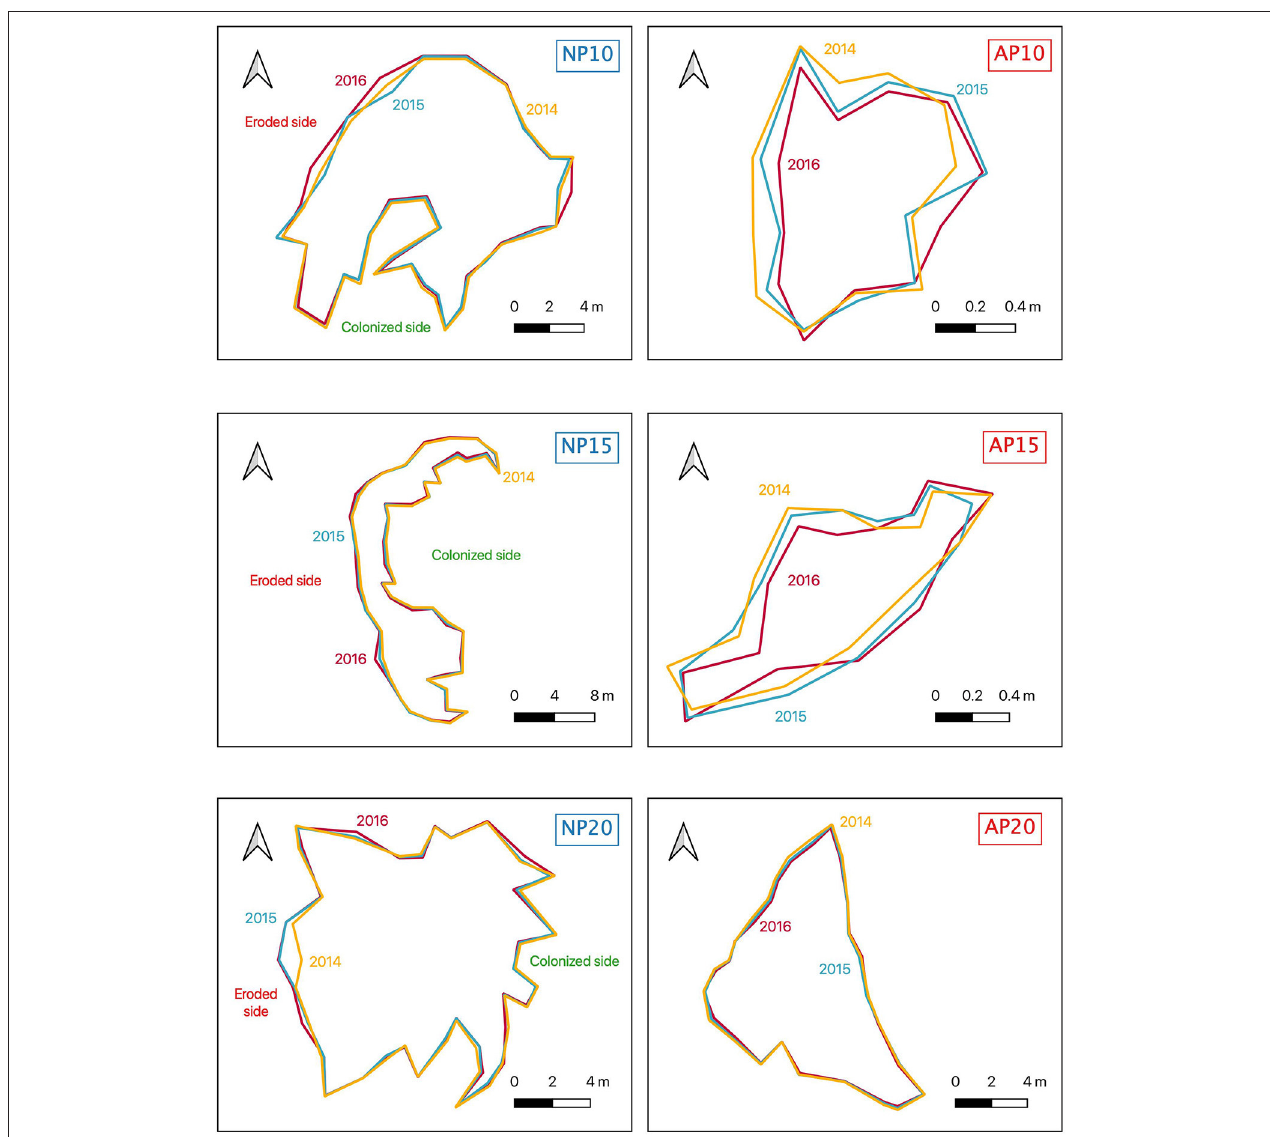
FIGURE 5 | Maps of the borders of natural (NP10, NP15, NP20) and anchoring patches (AP10, AP15, AP20) in 2014 (yellow), 2015 (blue), and 2016 (red). The position of the eroded and the natural sides are indicated for natural patches.